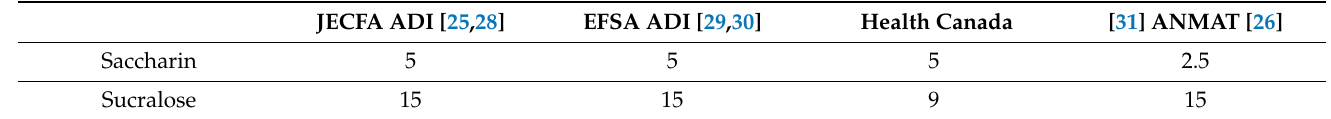
Table 1. Acceptable daily intake (ADI) (mg/kg/bw). JECFA ADI